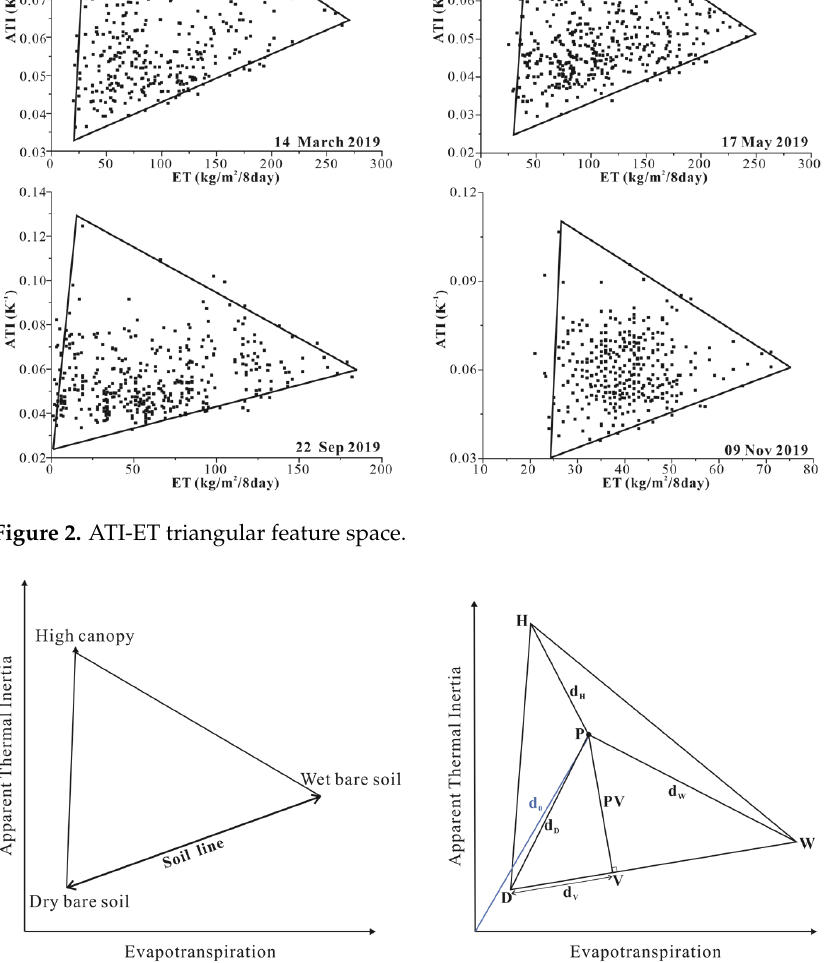
Figure 3. Six parameters used for estimating SM.